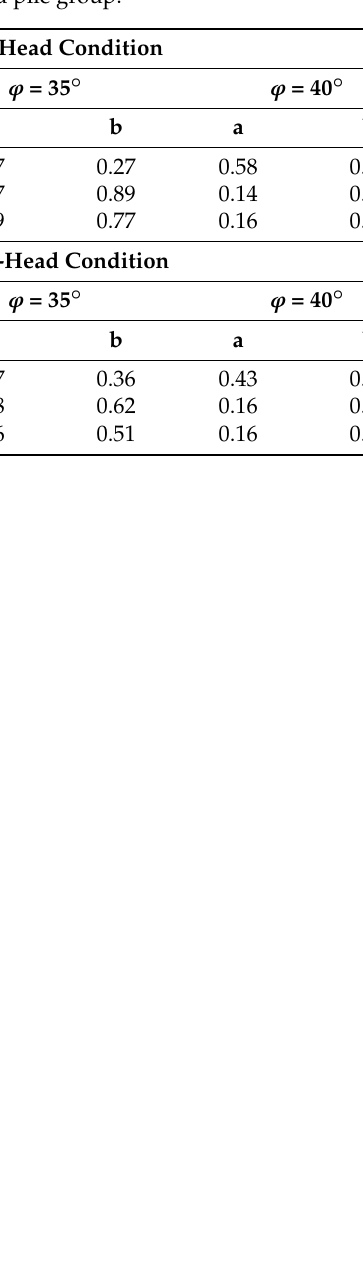
Table 5. Regression coefficients for free- and fixed-head pile group.